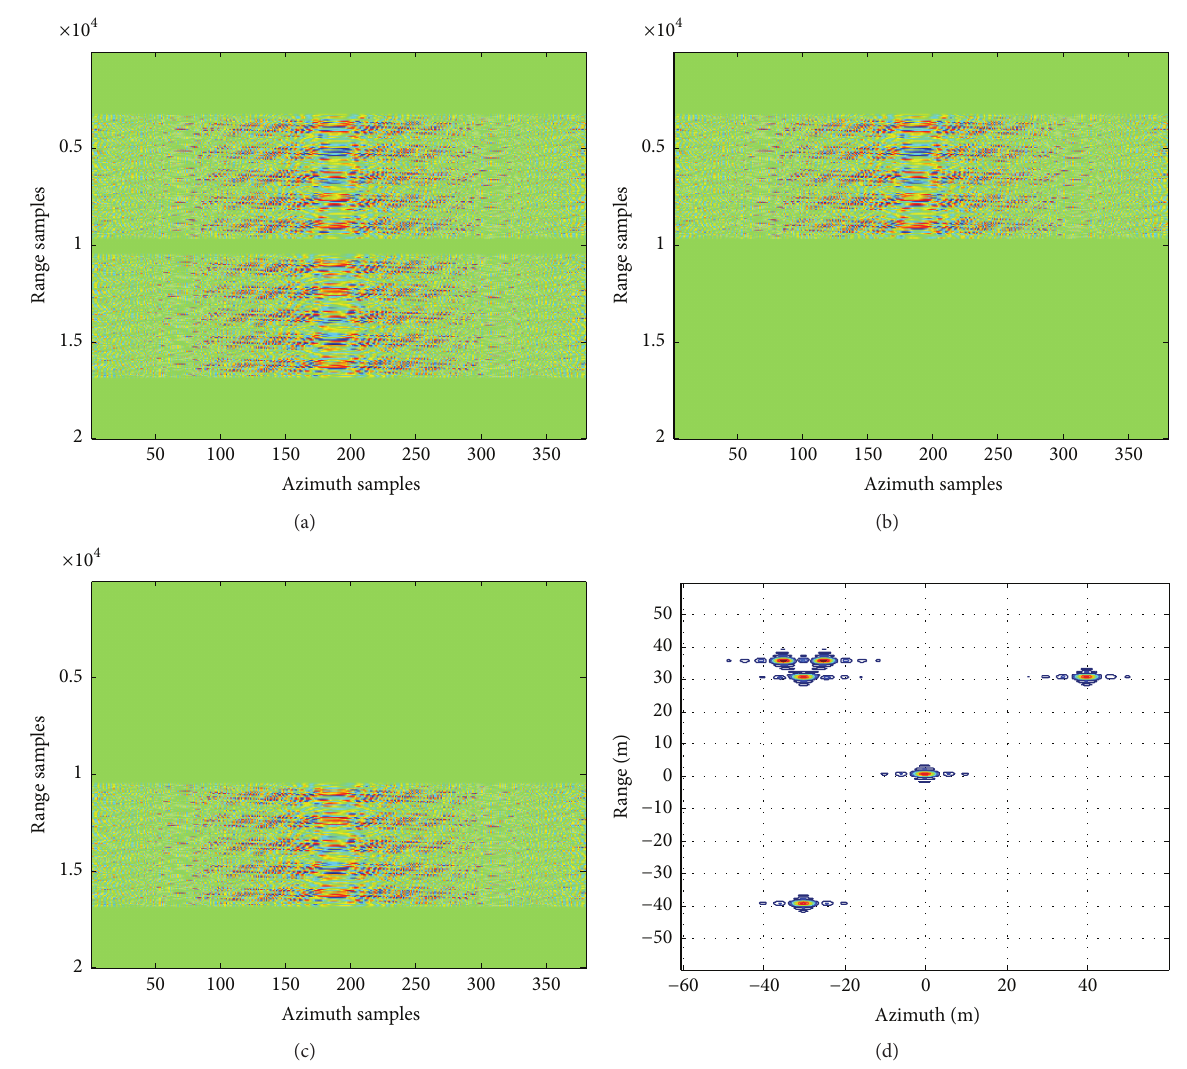
Figure 9: Simulation results of the designed scene. (a) Echoes received by one of the subapertures. (b) Echoes of the imaged scene corresponding to the first subpulse after DBF with null steering. (c) Echoes of the imaged scene corresponding to the second subpulse after DBF with null steering. (d) Two-dimension spectrum of the imaged